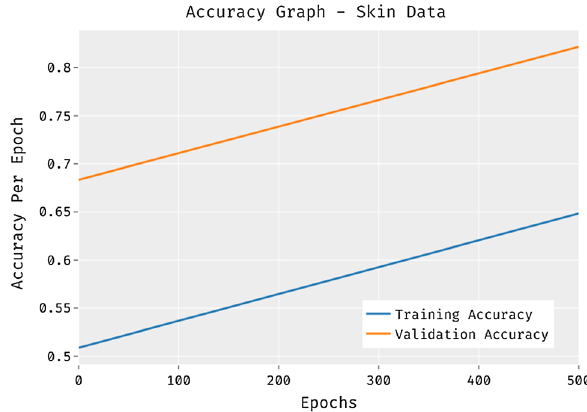
Fig. 10 Accuracy analysis of CICC-BDVMR technique under skin